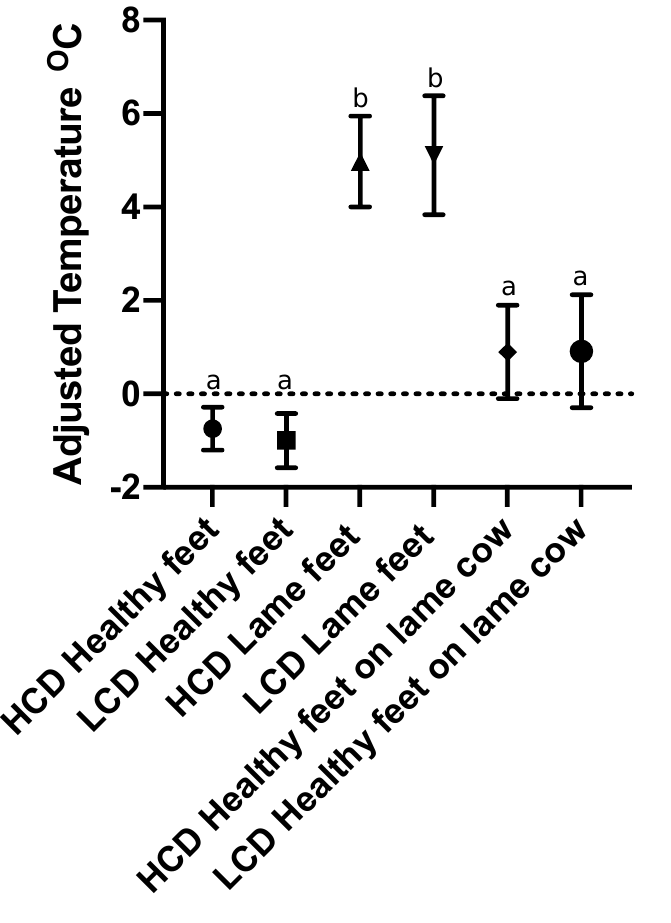
Figure 6. A graph showing the mean and 95% confidence interval of adjusted temperatures for the healthy cattle feet, lame cattle feet, and the non-lame feet present on a lame cow (n = 406, 121, and 115 for each group, respectively; both devices had an equivalent n in corresponding groups). The adjusted temperatures were calculated from the residuals from the mean healthy foot temperature on each data collection day. This graph shows both the data set obtained from the CAT S62-Pro Smartphone (LCD) and that from the FLIR T620bx (HCD). The dotted line at 0 represents foot temperatures equivalent to the mean temperature of healthy feet for the corresponding day of data collection. ab different superscripts indicate significant differences between means at p < 0.05.